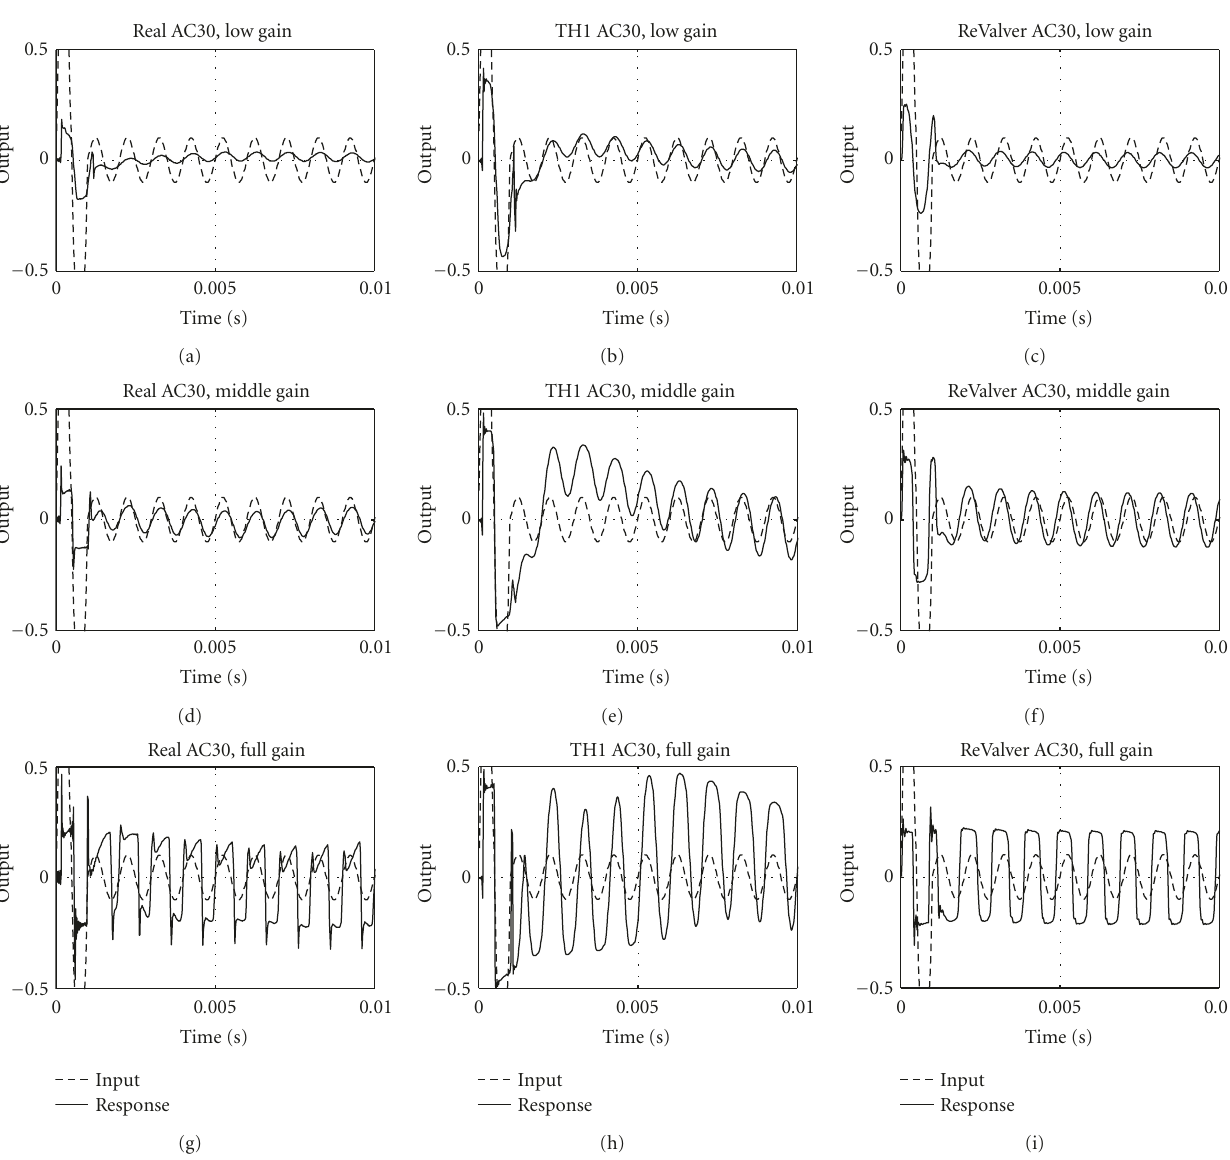
the user has aligned all the responses with the excitation,